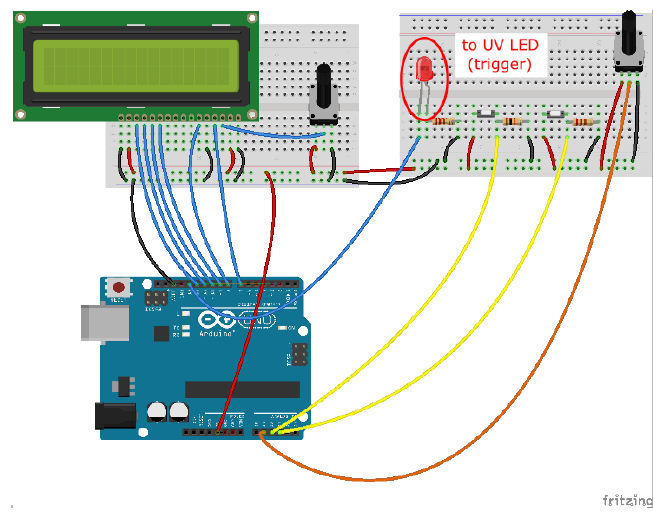
Figure A1. Photolithography set-up. Circuit diagram (made using Fritzing).